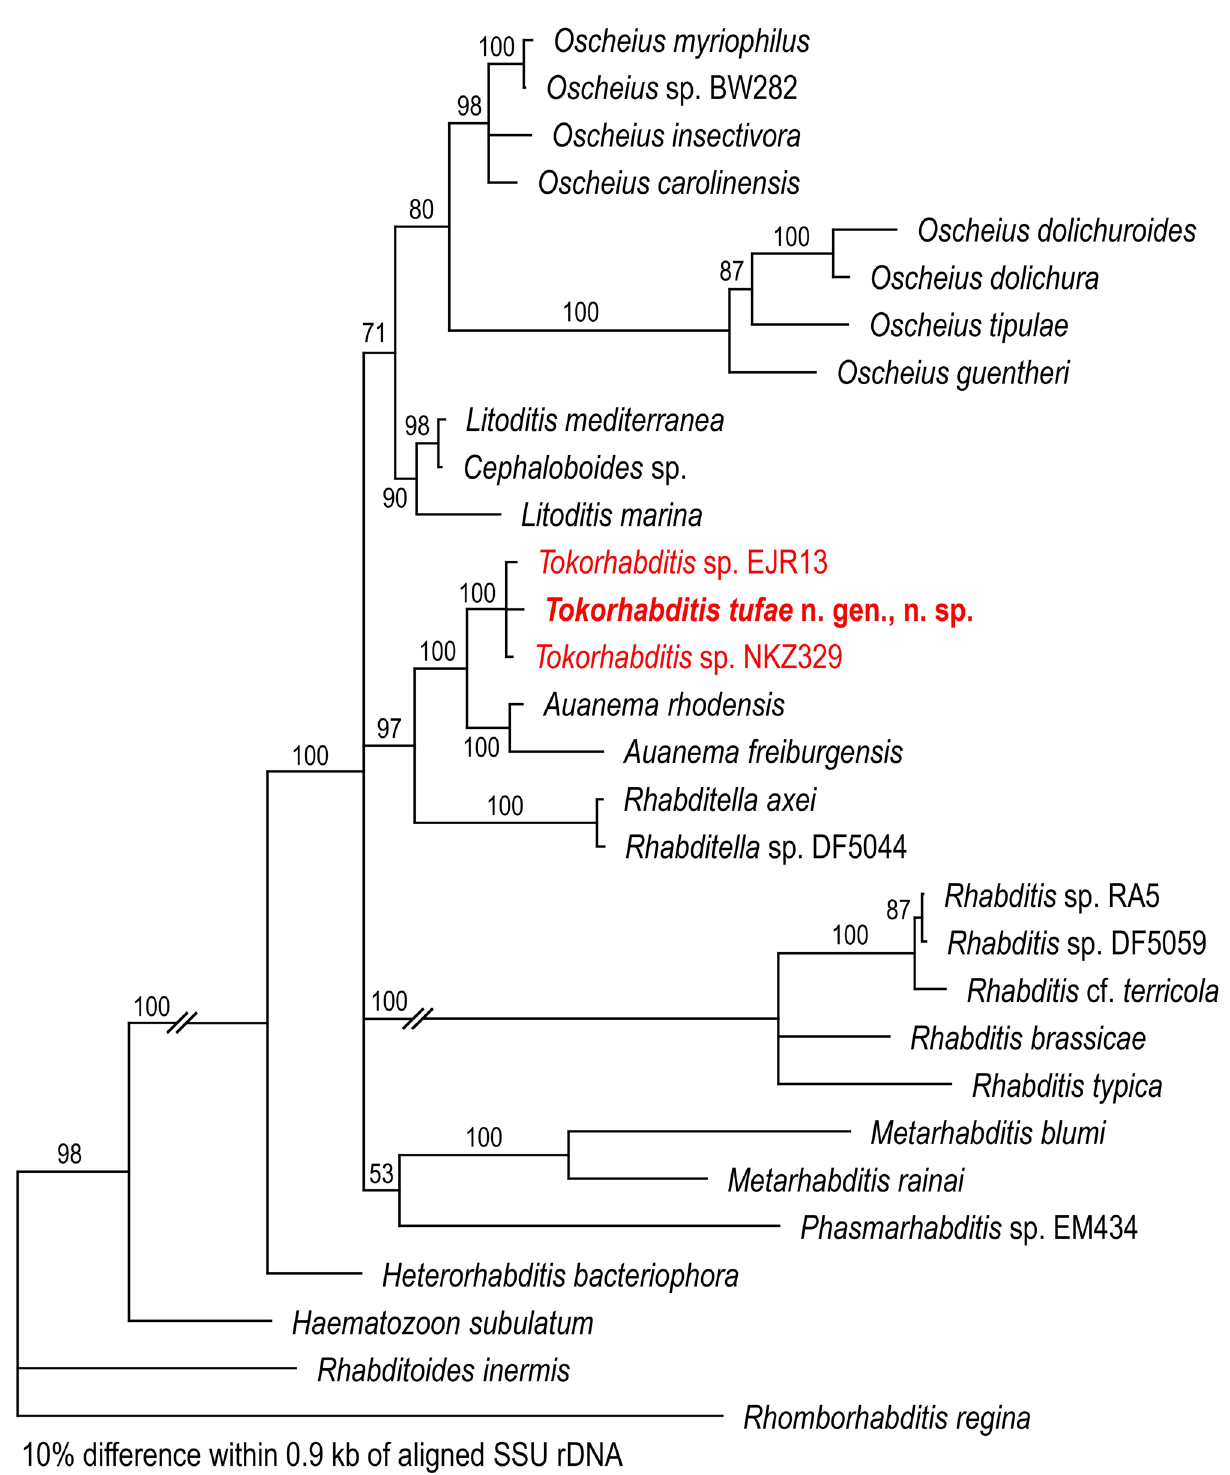
Figure 9. Phylogenetic status of Tokorhabditis n. gen. as inferred from SSU under GTR + G + I model (AIC = 13,794.546). Analytical parameters are: lnL = -8592.382; freqA = 0.27, freqC = 0.20. freqG = 0.25, freqT = 0.28; R(a) = 0.87, R(b) = 2.91, R(c) = 2.48, R(d) = 1.00, R(e) = 3.95, R(f) = 1.00; Pinva = 0.25; Shape = 1.16). Posterior probability values exceeding 50% are given on appropriate